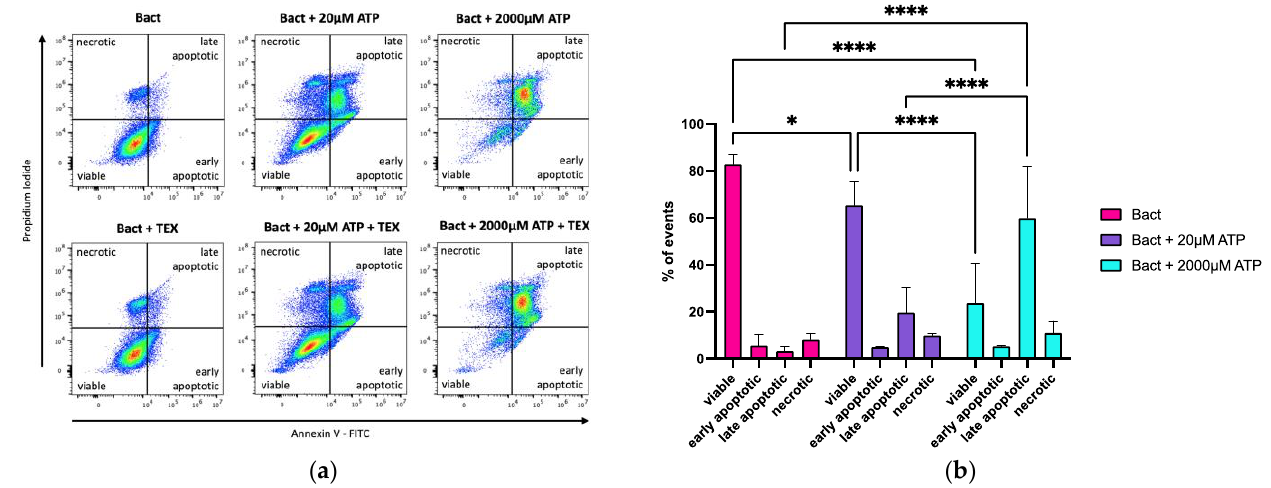
Figure 5. Flow cytometry analysis of annexin V and propidium iodide (PI) staining in activated B cells exposed to ATP and/or TEX. ( a ) Adding ATP to activated B cells (Bact) induced apoptosis in B cells, especially the high 2000 µM ATP dose (upper panel). TEX (10 µg/mL) did not appear to alter apoptosis or necrosis (lower panel). FITC = fluorescein isothiocyanate. ( b ) Bar charts showing the influence of ATP and TEX on cell death in B cells by annexin V and PI staining. The mean of three independent experiments with standard deviation is presented. ATP significantly reduced the via- bility of activated B cells and pushed them towards apoptosis (viable: Bact vs. Bact + 20 µM ATP: p * = 0.0384; Bact vs. Bact + 2000 µM ATP: p **** < 0.0001; Bact + 20 µM ATP vs. Bact + 2000 µM ATP: